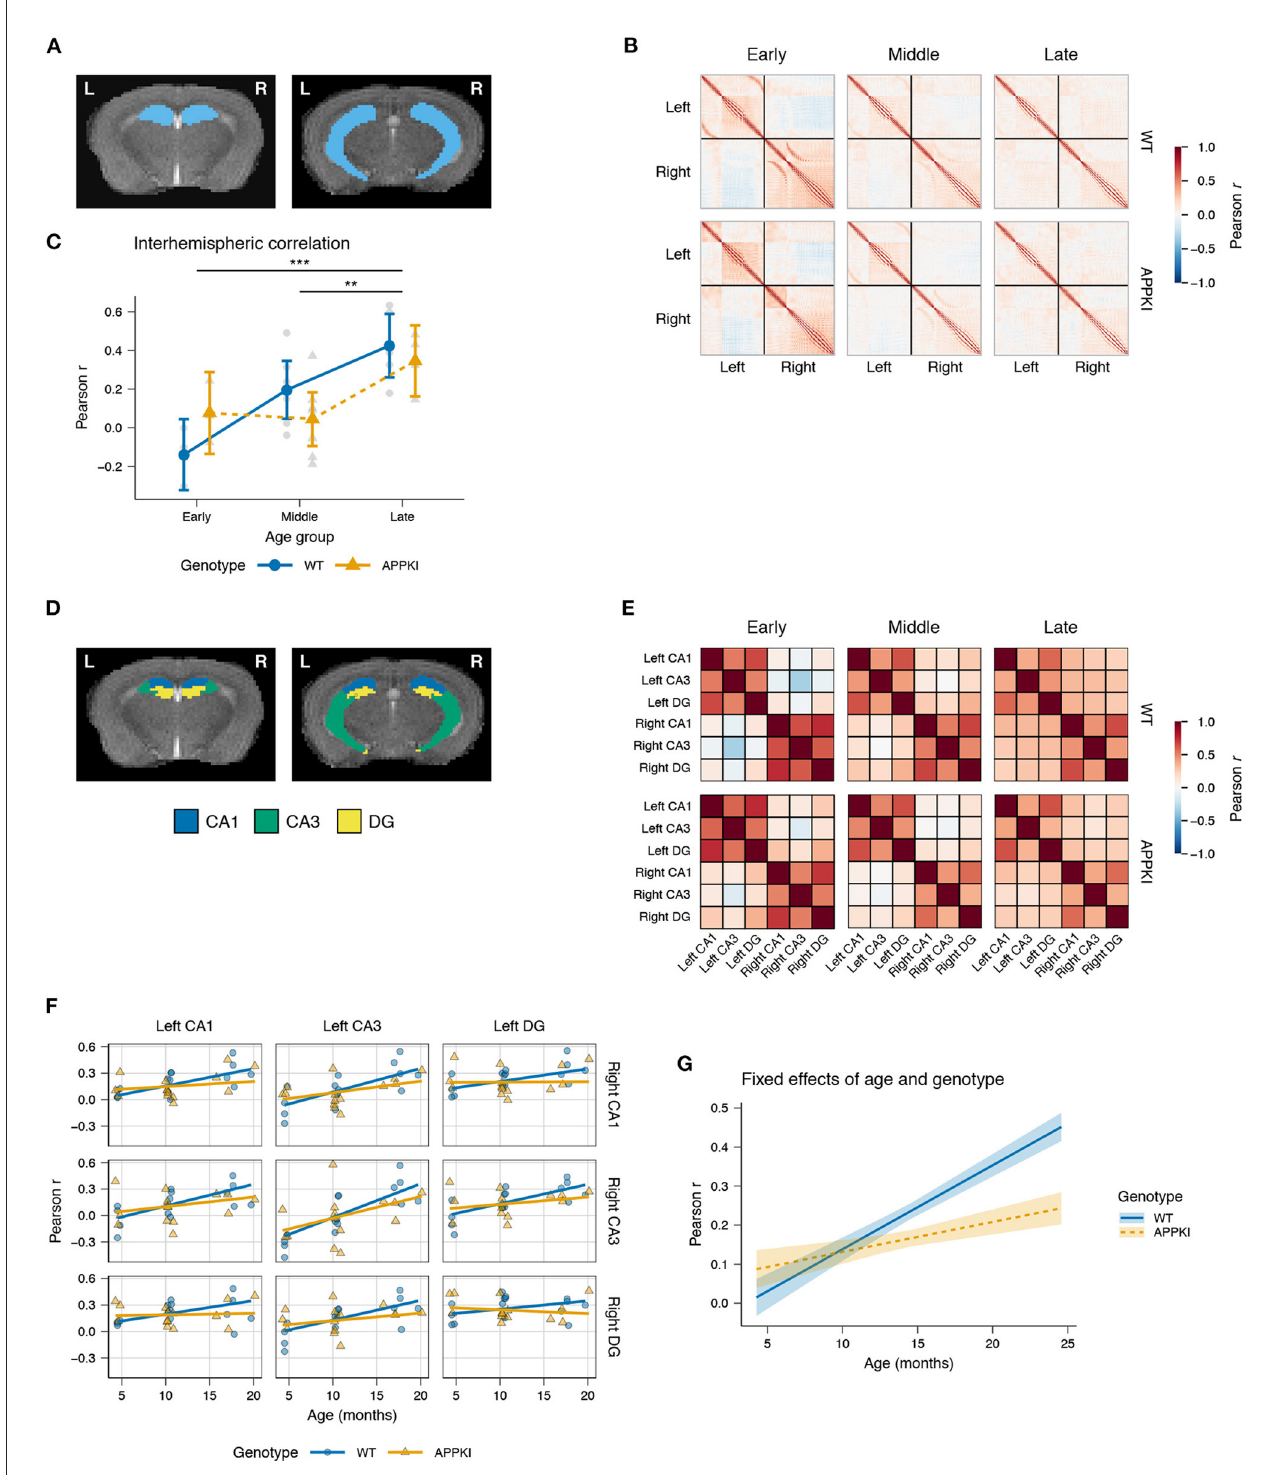
FIGURE2 Hippocampal interhemispheric correlation by age and genotype. (A) Representative T 2 -weighted images of coronal slices containing the hippocampus. (B) Group average Pearson correlation matrices for each voxel in the hippocampus. Black lines demarcate the left and right hemispheres (upper left and lower right, respectively). (C) Lineplot of the interhemispheric Pearson correlation by age group and genotype. Gray points represent the mean interhemispheric FC for each subject. Colored points represent group mean. Error bars represent 95% CI. (D) Representative atlas images of the hippocampal CA1, CA3, and DG. (E) Pearson correlation matrices of the average time series for each subregion, averaged across group. (F) Linear mixed model fit of interhemispheric correlation by age and genotype, with a random intercept for each subregion and a random slope for age within subregion. Points represent mean interhemispheric FC for each subject. Lines represent model fit. (G) Fixed effects of age and genotype. Lines represent model fit. Shaded areas represent standard error. Blue: wild-type; orange: App NL-G-F/NL-G-F . *** p < 0.001; ** p <